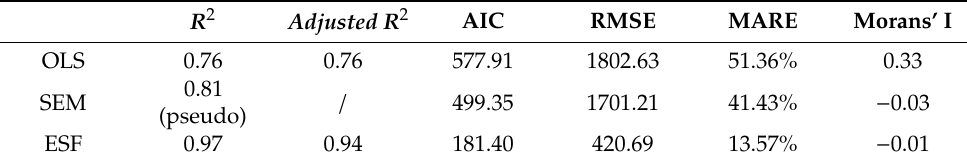
Table A2. Model performance without NTL variable in 2015.